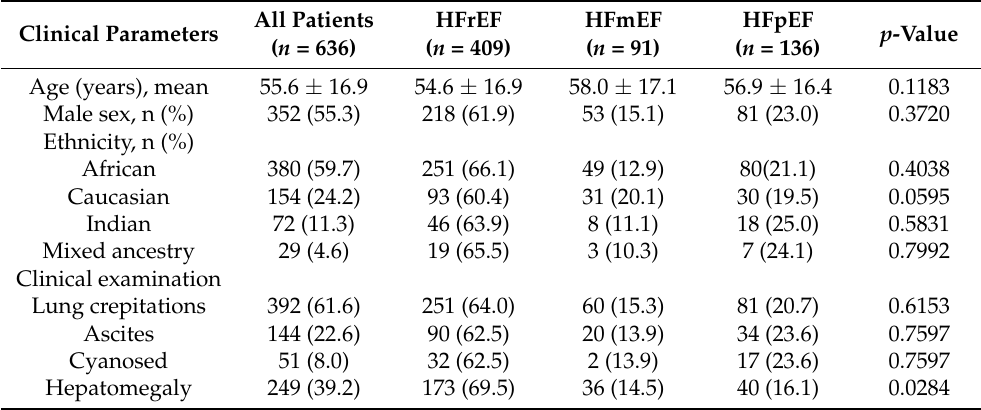
Figure 2. Clusters of heart failure patients identified by agglomerative clustering. ( A ) Dendrogram showing three clusters. Cluster 1 (orange), cluster 2 and 3 (green). Three clusters were selected based on the silhouette score of 0.7, which is a measure of goodness of fit of patients into each cluster. The x-axis shows various clusters, and the y-axis shows the average distance between clusters. ( B ) A two-dimensional scatterplot of the three clusters of heart failure patients identified by the agglomerative clustering algorithm. The x- and y-axis represent principal component 1 and 2, respectively. Each component represents a constellation of clinical features that were used to cluster data points. Table 3. Baseline demographic and clinical characteristics of the study patients stratified according to clusters.